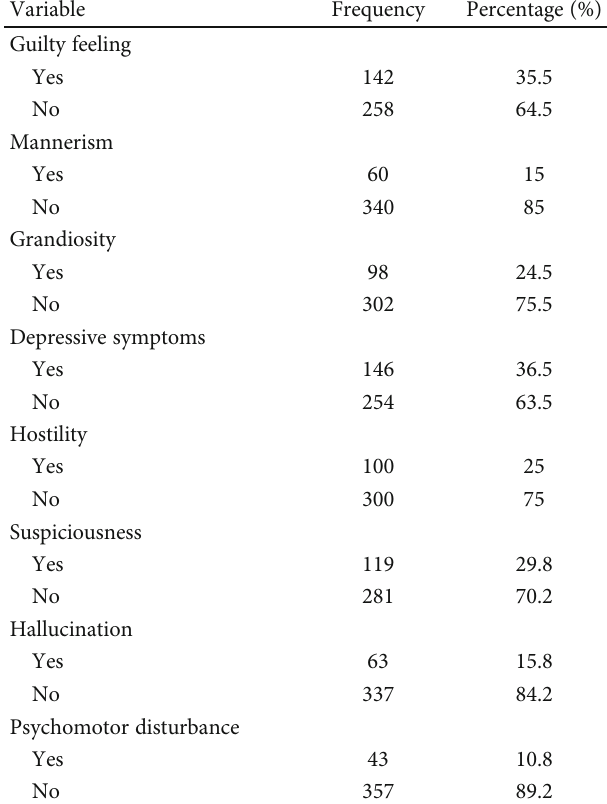
Table 2: Clinical characteristics and current psychopathology of patients with bipolar disorder ( n = 400 ) at the Amanuel Mental Specialized Hospital, 2015.